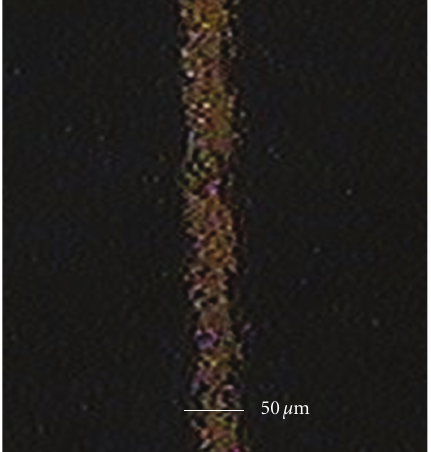
Figure 16: Image of MCS printed 50 μ m wide copper line on glass, from Bhattacharya et al. [11], Copyright 2012 ASME. Reprinted with permission.